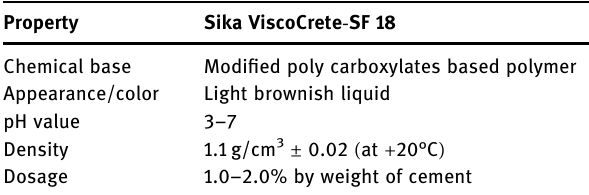
Table 7: The characteristics of super - plasticizer used